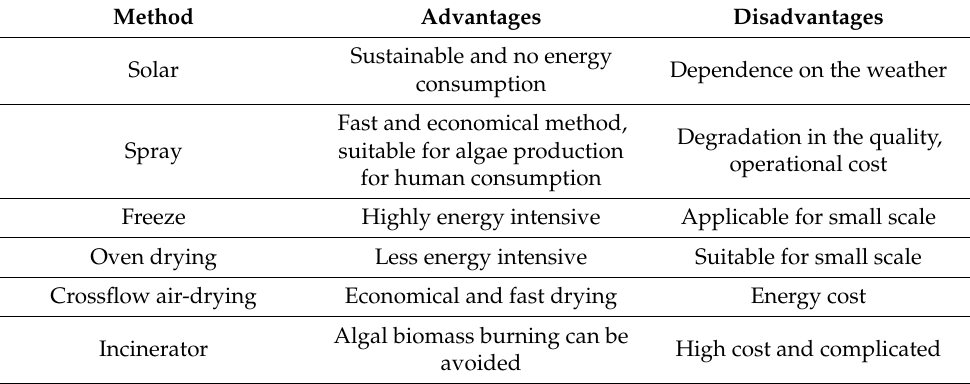
Table 9. Advantages and disadvantages of the most common microalgae biomass-drying technolo- gies